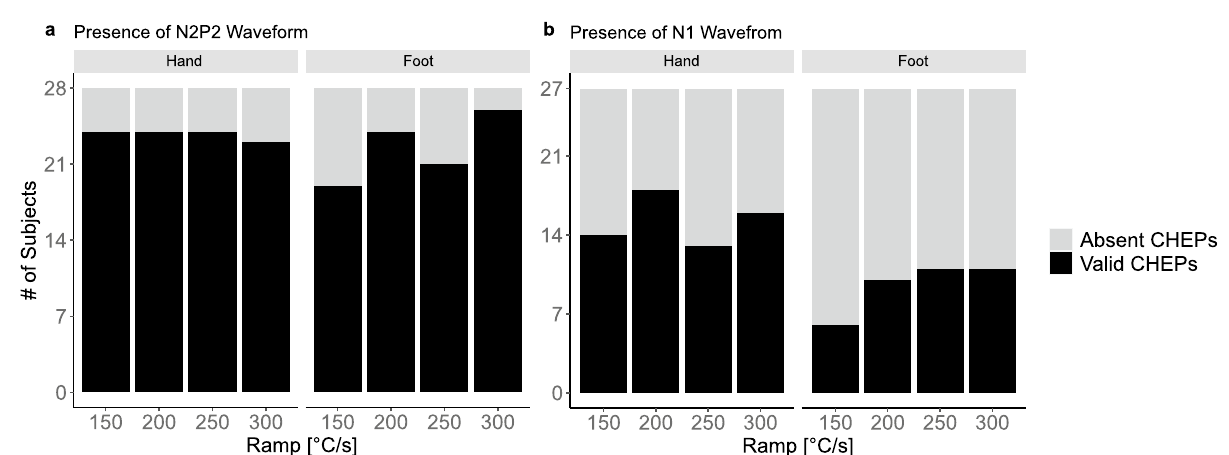
Figure 2. Number of present contact heat evoked potentials (CHEPs). ( a ) Number of present N2P2 and ( b ) N1 waveforms when stimulating the hand (left) and foot (right). The y-axis illustrates the number of subjects with absent (gray) and valid (black) CHEPs.